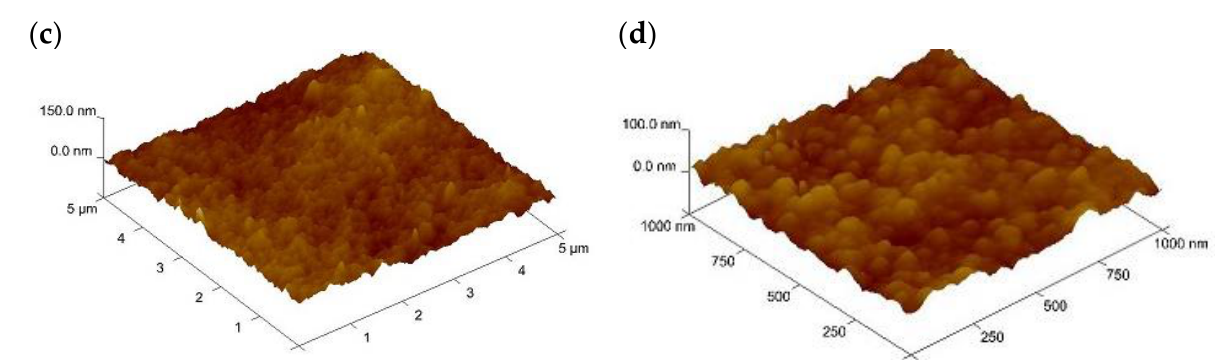
Figure 6. The 2-D ( a , b ) and 3-D ( c , d ) images of atomic force microscopy (AFM) for the CTA membrane (left) and the “optimal” polymer inclusion membrane (PIM) (right).